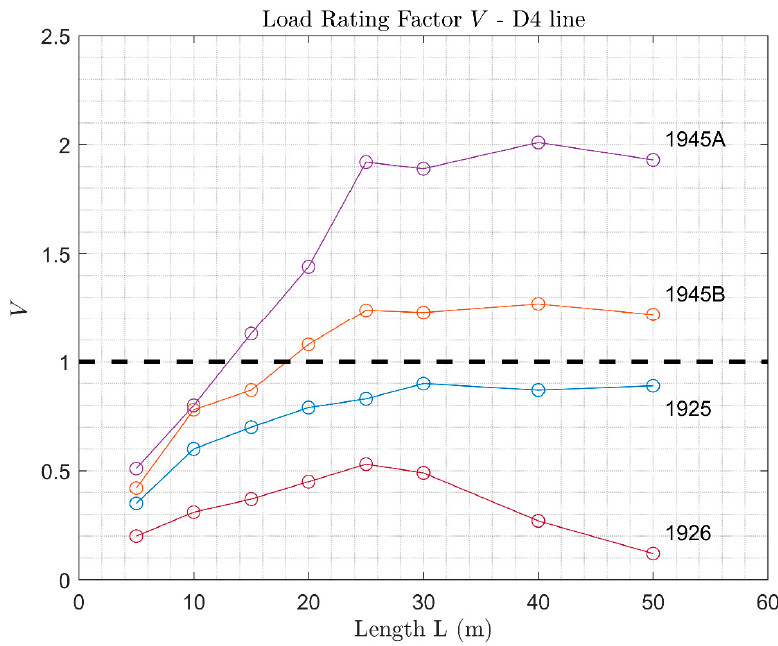
Figure 16. Load Rating Factor of arches verified with D4 loads, with dynamic amplification.